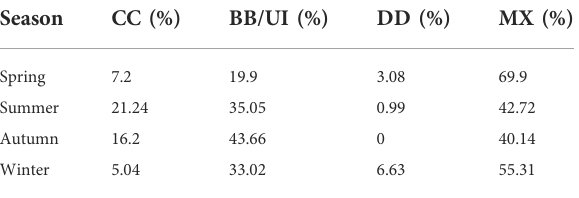
TABLE 2 Proportions of aerosol types in different